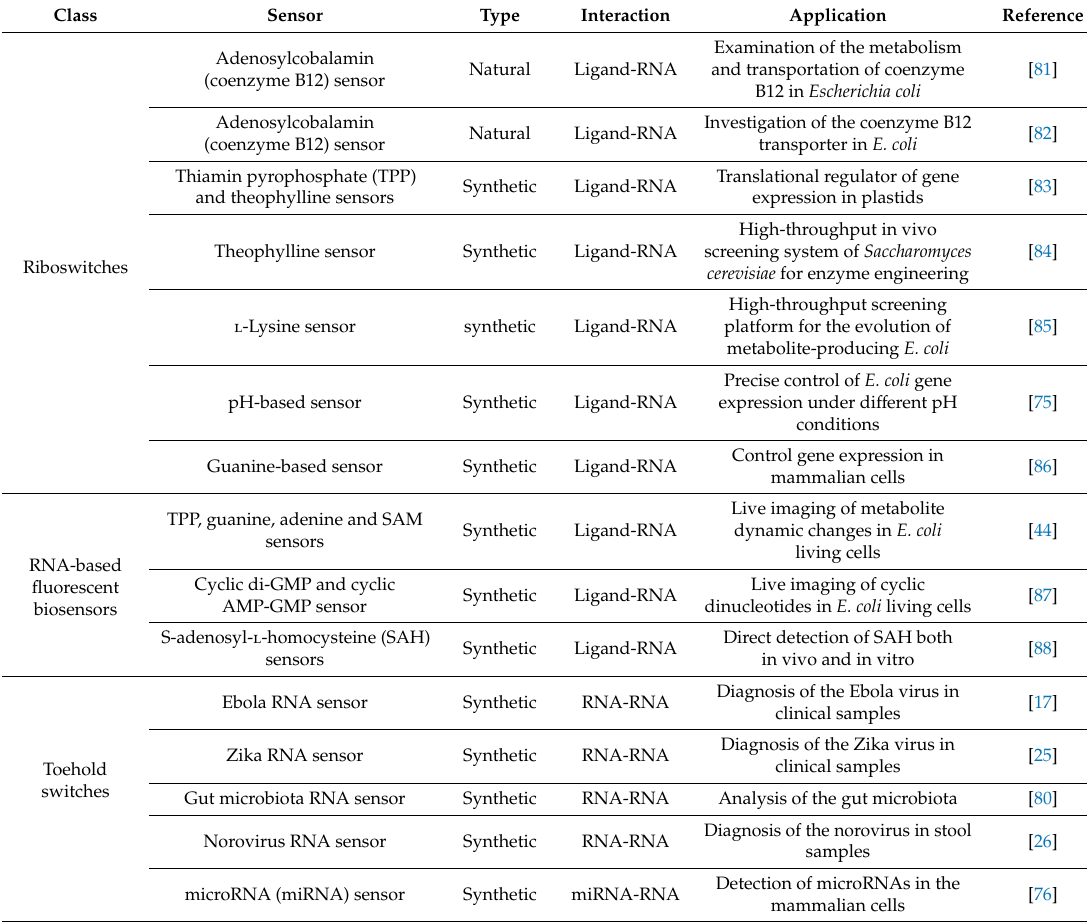
Table 1. Recent advancements of riboswitches and toehold switches in molecular